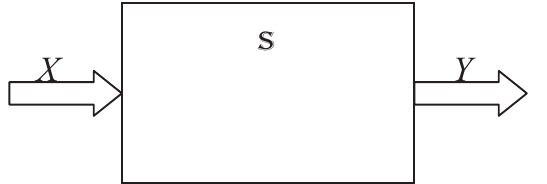
Fig. 1. Diagram of an abstract model of cognitive